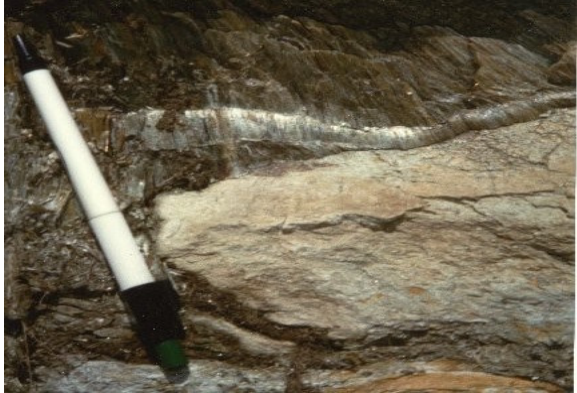
Figure 1: A photograph of the fibrous antigorite shown as perpendicular to vein selvages in serpentinitic rock. A 15 cm pen was used as a size